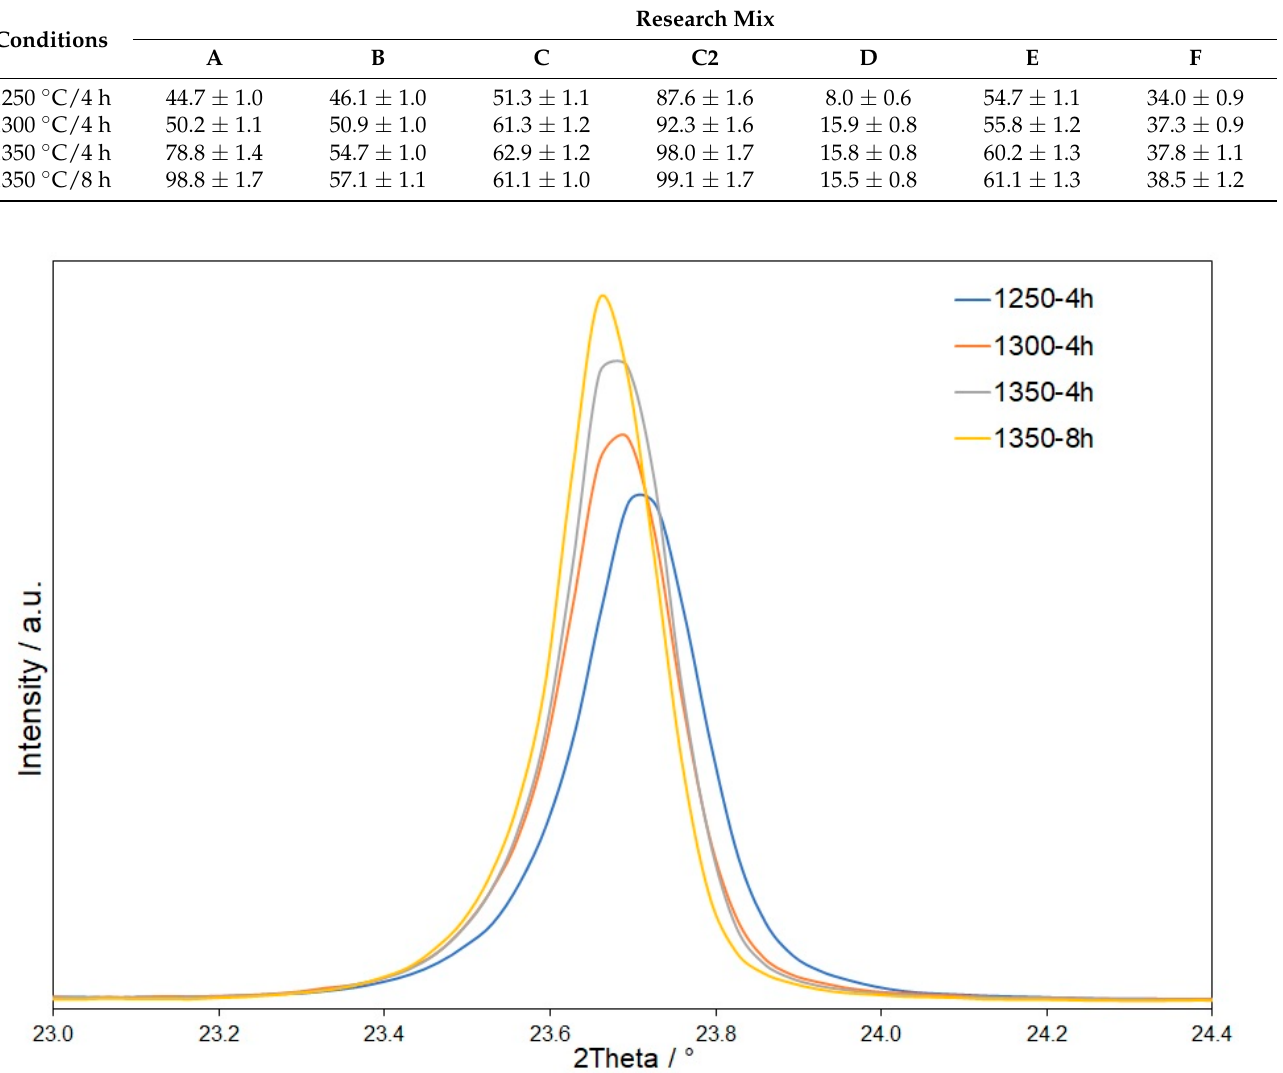
Figure 7. Changes of main ye’elimite XRD reflex for C2 series under different conditions of synthesis.